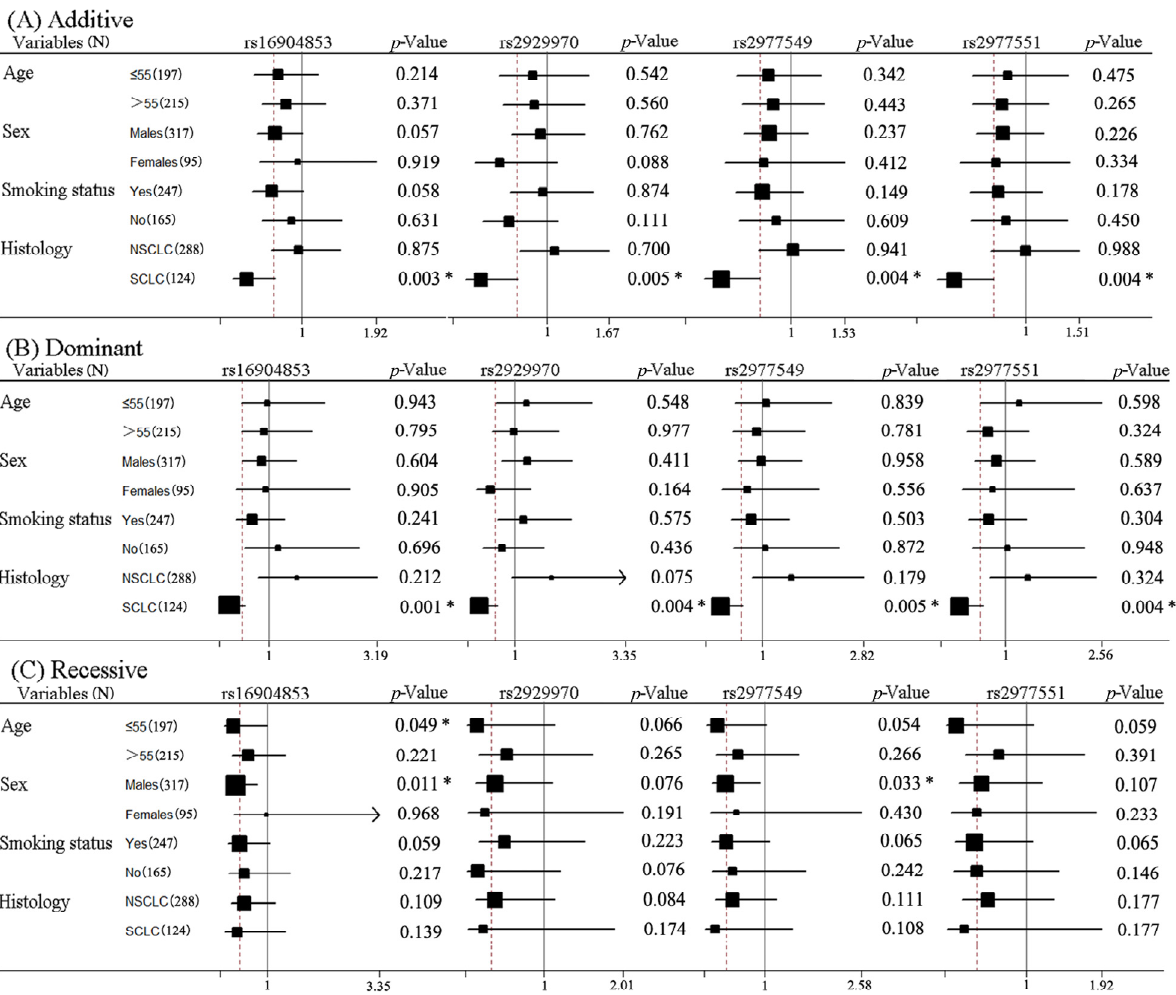
Figure 2. Stratification analyses of the associations of WISP1 rs16904853, rs2929970, rs2977549 and rs2977551 polymorphisms with the hematologic toxicity of lung cancer. Each box and horizontal line represents the values of OR and 95% CI. NSCLC, non-small cell lung carcinoma; SCLC, small cell lung carcinoma. * p <